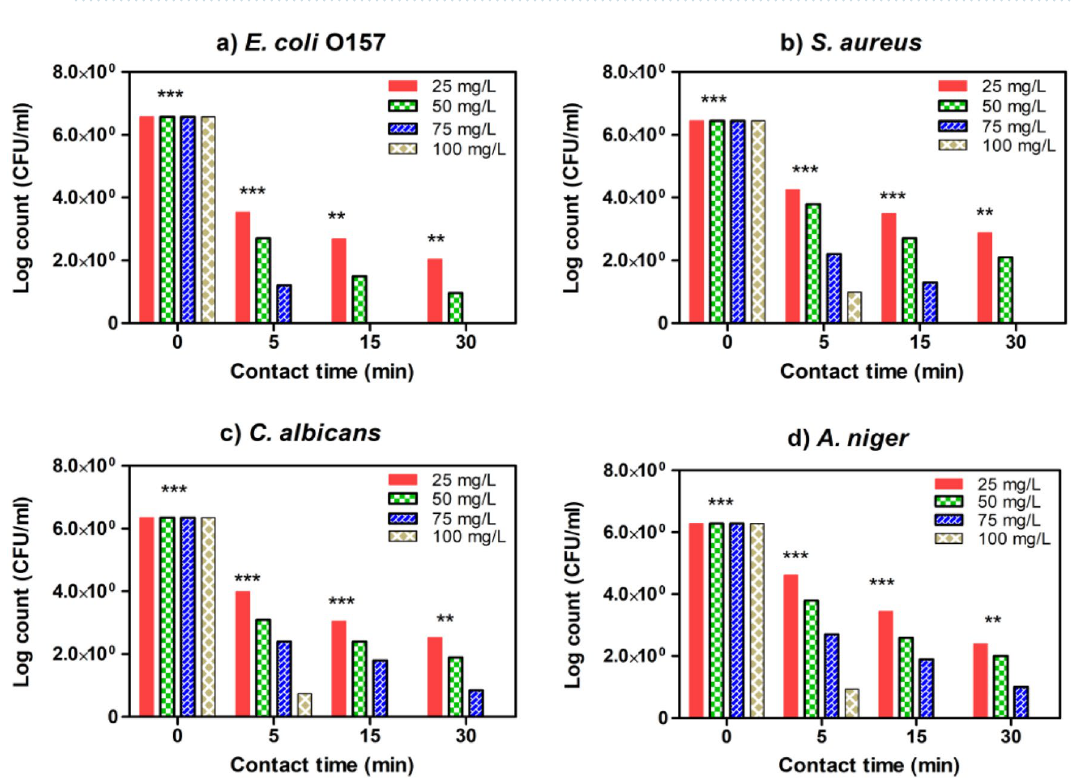
Figure 11. Estimated MIC values of SMZC-0.7Ni towards four tested microbial species, including ( a ) E. coli , ( b ) S. aureus , ( c ) C. albicans , and ( d ) A. niger . The remaining viable cell populations at various time intervals of 5, 15, and 30 min are